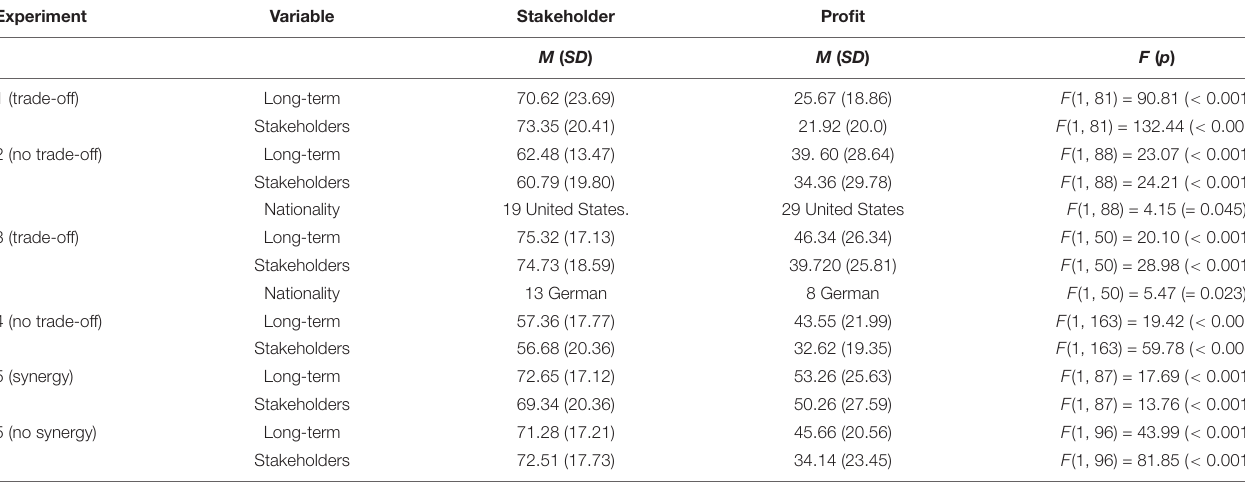
TABLE 1 | Means, standard deviations, and significance levels of manipulation checks and control variables in experiments 1–5. Experiment